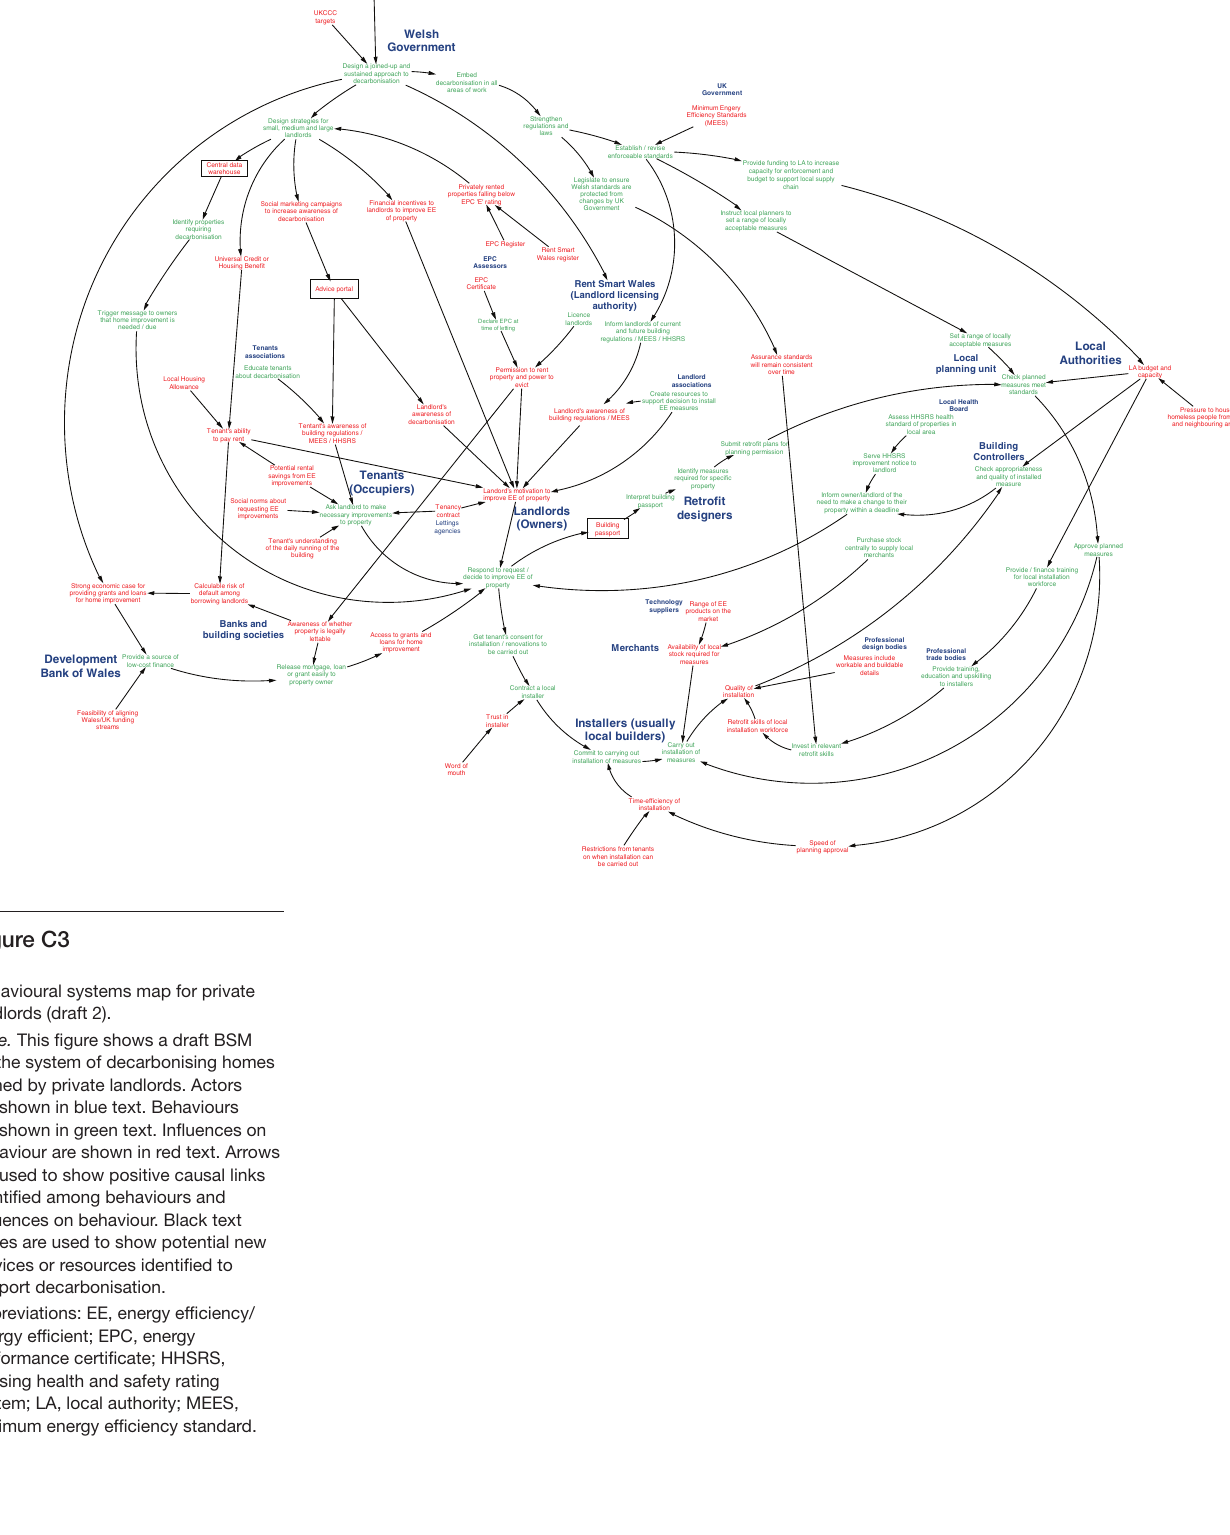
Behavioural systems map for private landlords (draft 2). Note. This figure shows a draft BSM for the system of decarbonising homes owned by private landlords. Actors are shown in blue text. Behaviours are shown in green text. Influences on behaviour are shown in red text. Arrows are used to show positive causal links identified among behaviours and influences on behaviour. Black text boxes are used to show potential new services or resources identified to support decarbonisation. Abbreviations: EE, energy efficiency/ energy efficient; EPC, energy performance certificate; HHSRS, housing health and safety rating system; LA, local authority; MEES, minimum energy efficiency